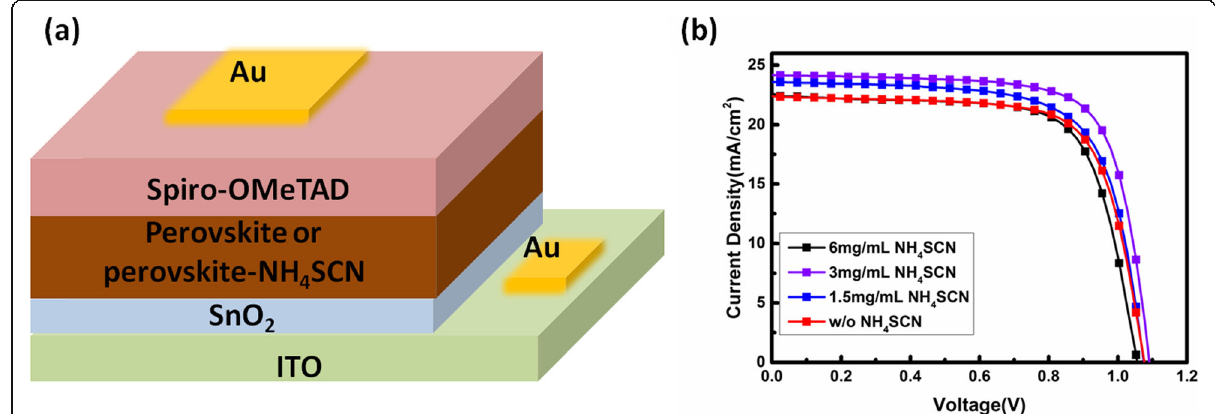
Fig. 1 a Schematic illustration of PSCs structure. b J-V curves of PSCs based on perovskite films deposited from perovskite precursors doped with different NH 4 SCN